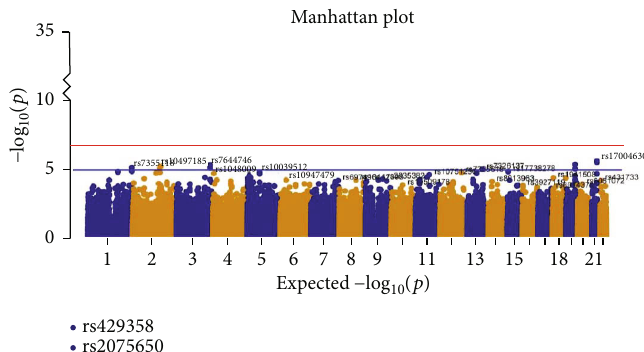
Figure 2: Manhattan plot of genome-wide association study (GWAS) between AD and HC groups. The y -axis shows the p value (on the – log10 scale) for each association test. The x -axis is the chromosomal position of each SNP. The horizontal lines in the Manhattan plot display the cuto ff s for two signi fi cant levels: blue line for p < 10 − 5 (generally signi fi cant level) and red line for p < 1 : 66 e − 7 . Q - Q plot of GWAS